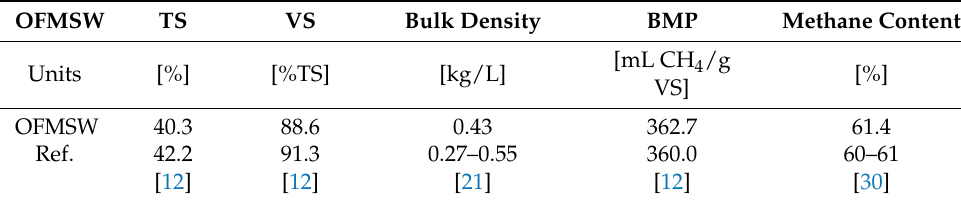
Table 4. Parameters assumed for the characterization of OFMSW.